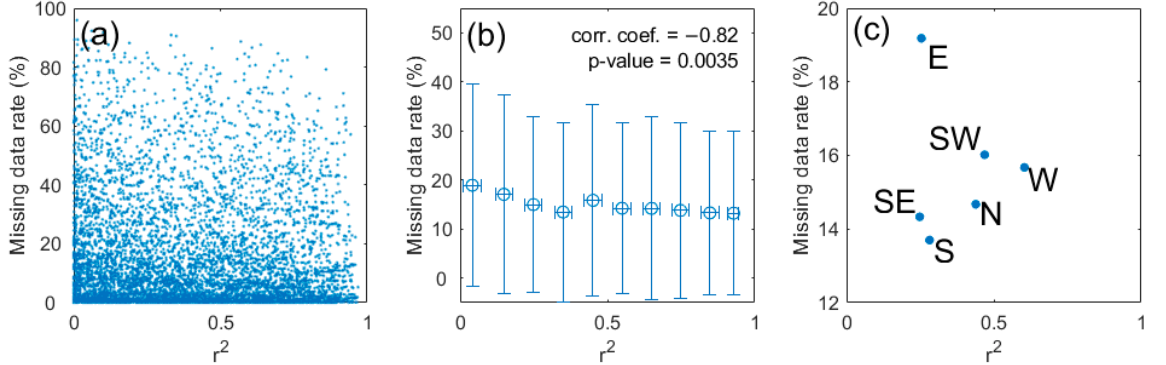
Figure 10. ( a ) Scatter plot of r 2 and SST O missing data rate. ( b ) Scatter plot of r 2 and averaged SST O missing data rate per 0.1 interval of r 2 , bars are error bars of one standard deviation. ( c ) Scatter plot of r 2 and SST O missing data rate for the six